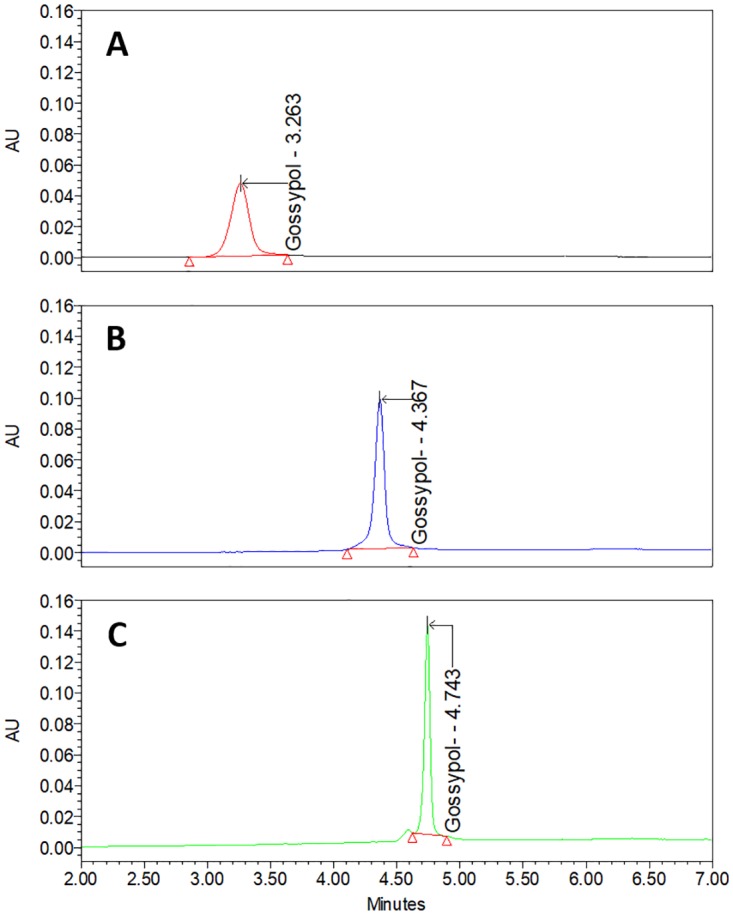
UHPLC chromatograms of standard gossypol generated following comparison of different elution organic phases.(Gradient elutions with organic phases composed of (A) 100% acetonitrile (ACN), (B) 50% ACN/50% methanol (MeOH), and (C) 100% MeOH.